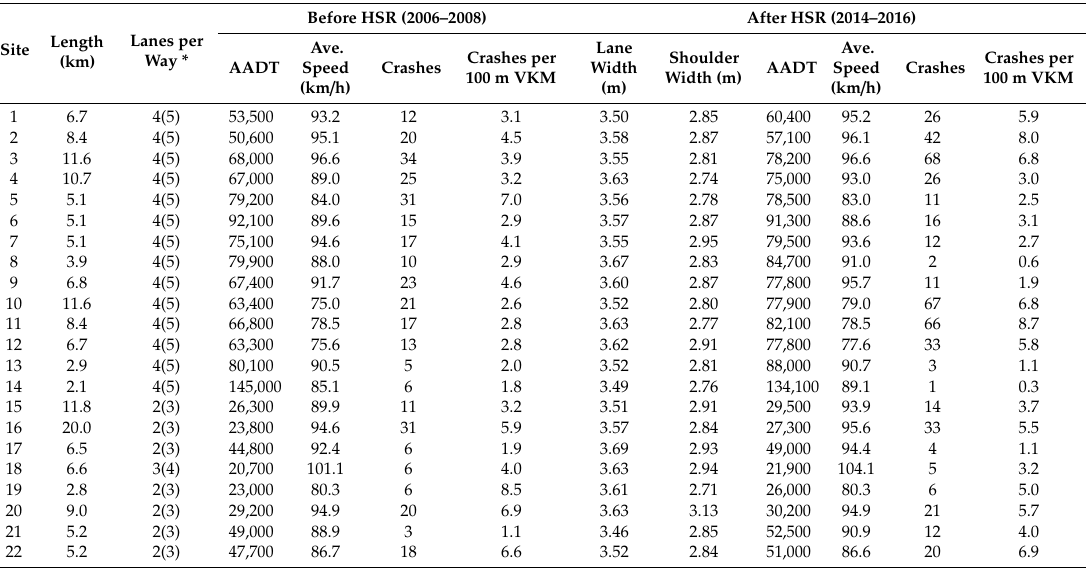
Table 1. Tra ffi c and roadway factors, before and after